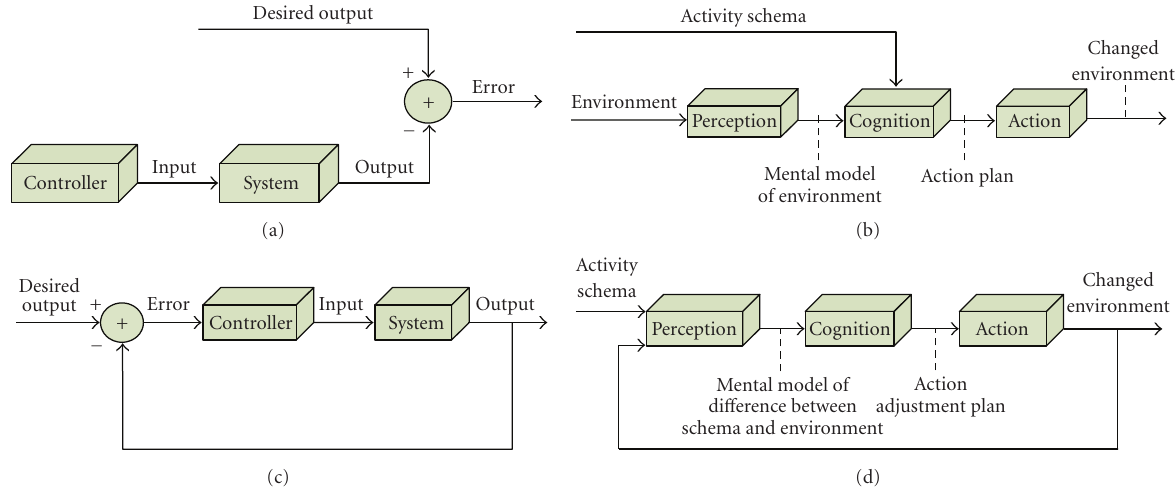
Figure 1: Analogy between closed loop control and embodied interaction.